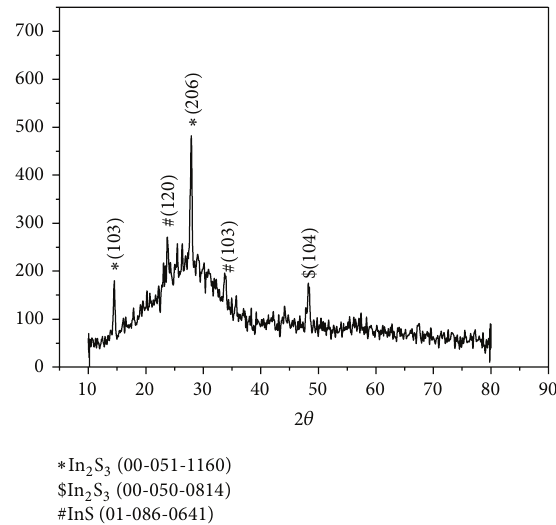
Figure 3: The XRD pattern of In 2 S 3 film annealed at 400 ∘